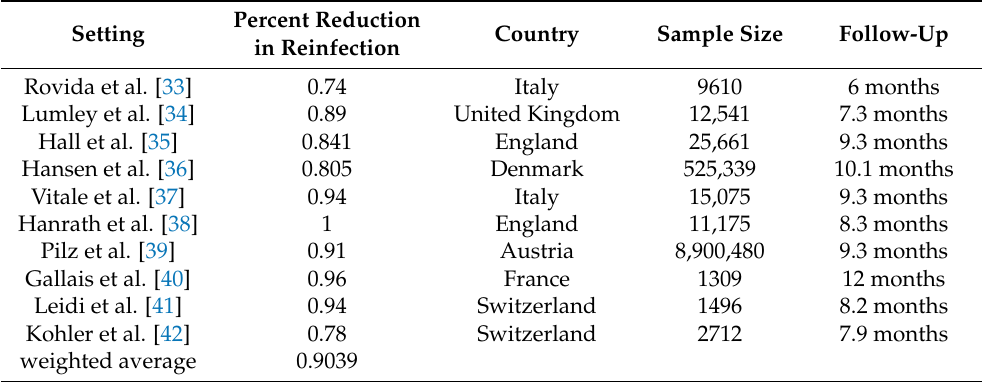
Table 1. Comparison of studies assessing the degree of reduction in risk of reinfection compared to primary infection (namely, the protective effects of infection-induced immunity).